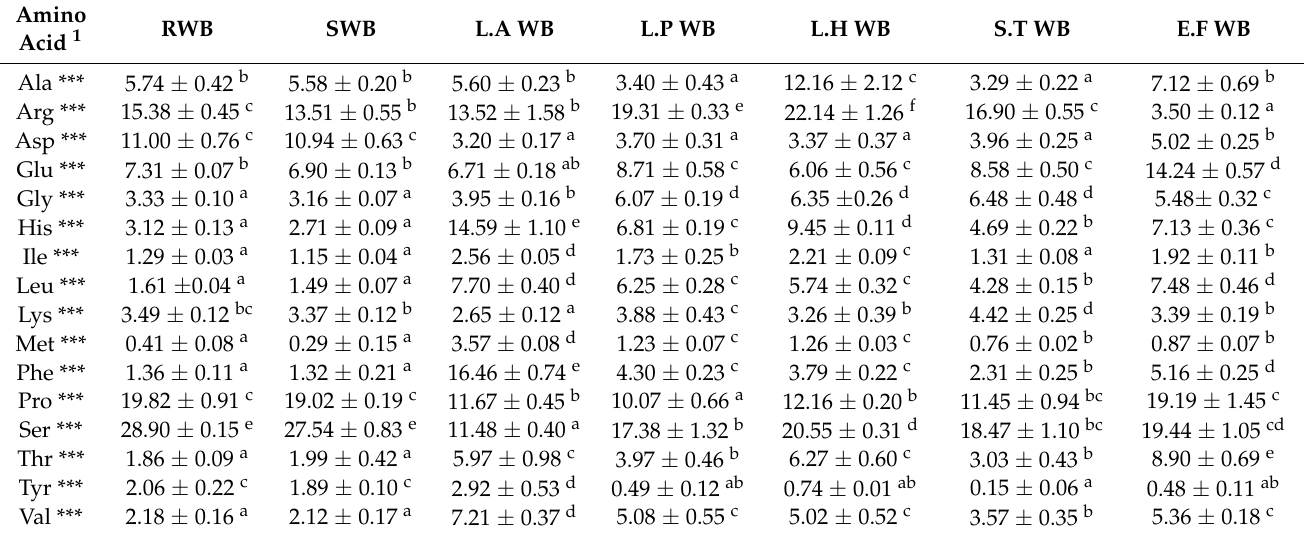
Table 2. Amino acid profiles of raw and fermented wheat